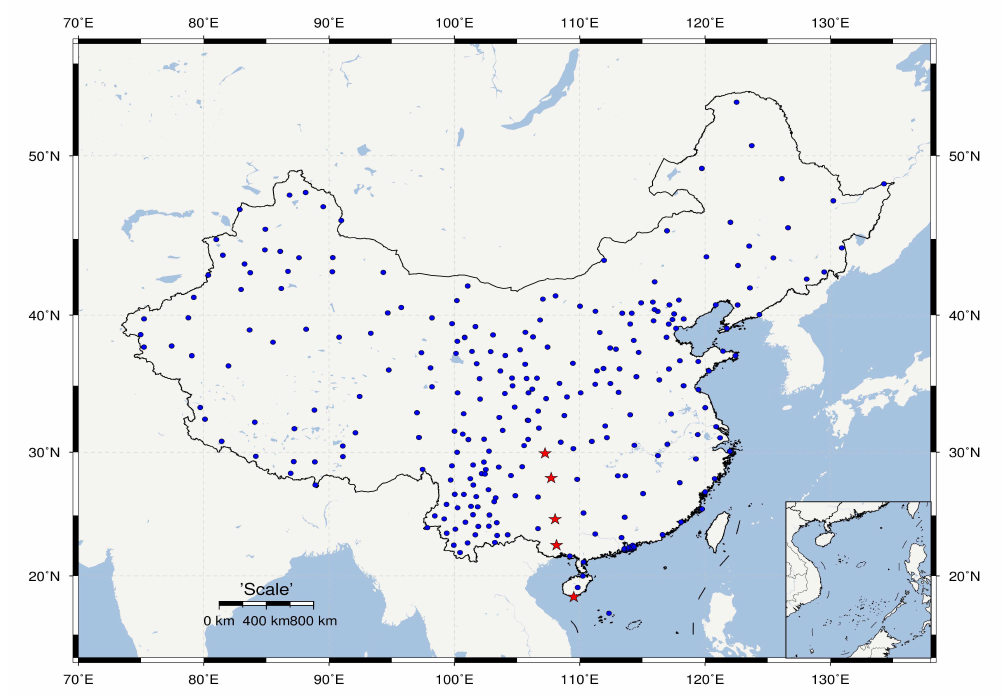
Figure 1. Distributions of the CMONOC GNSS stations (blue dots) and five stations at low latitude (red